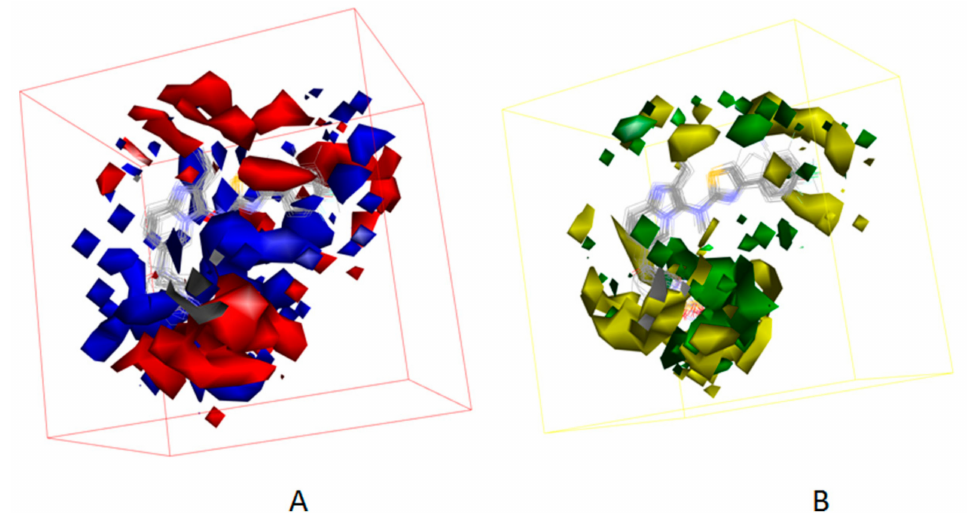
Figure 7. ( A ) 3D QSAR model coe ffi cients on electrostatic potential grids. Blue represents positive coe ffi cients; red represents negative coe ffi cients. ( B ) 3D QSAR model coe ffi cients on van der Waals grids. Green represents positive coe ffi cients; yellow represents negative coe ffi